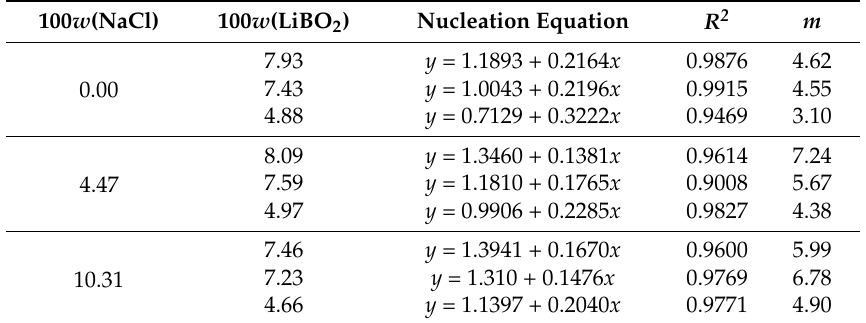
Table 4. Apparent order m of lithium metaborate salts in the solution containing sodium